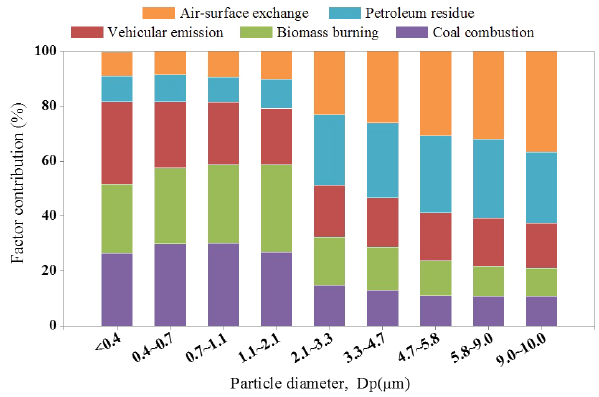
Figure 9. Factor contributions to size-segregated particles by the PMF model from full PAH data sets.